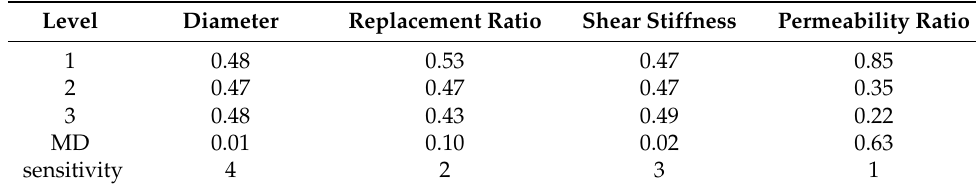
Table 6. Range analysis of